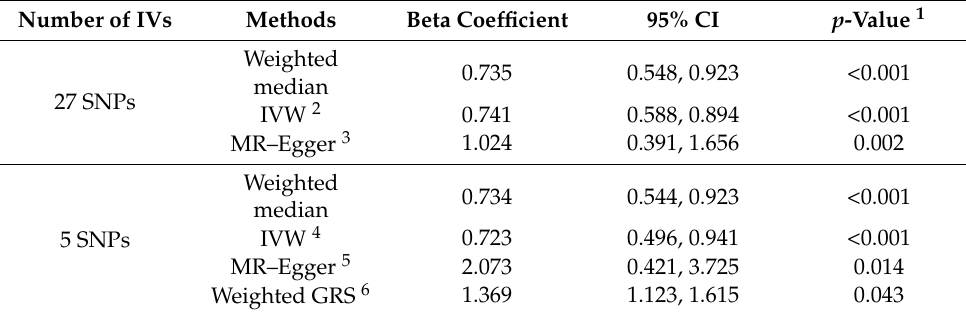
Table 5. Estimates from MR methods for the association between Hcy and